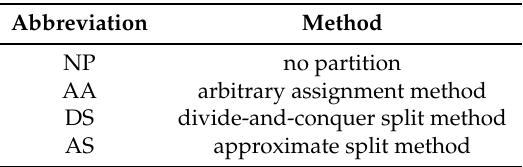
Table 5. Method comparison in experiment